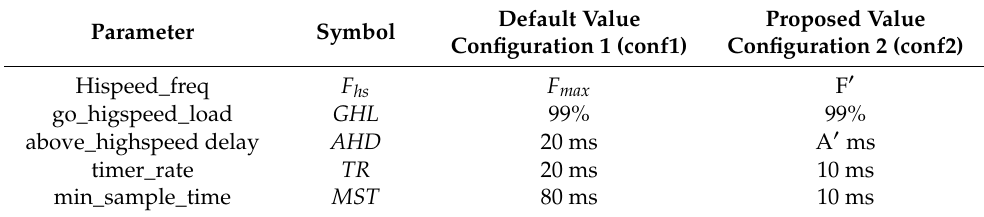
Table 2. Interactive default parameters values and proposed values.